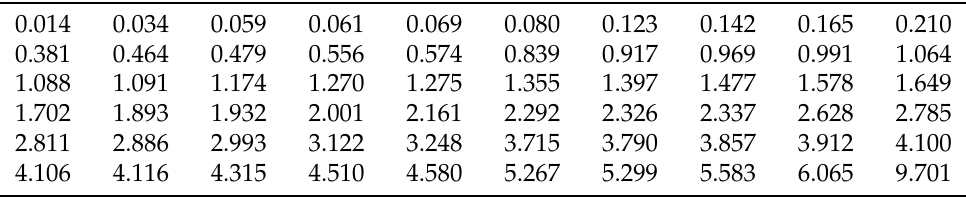
Table A3. Complete data set of the number of 1000s of cycles to failure for electrical appliances.